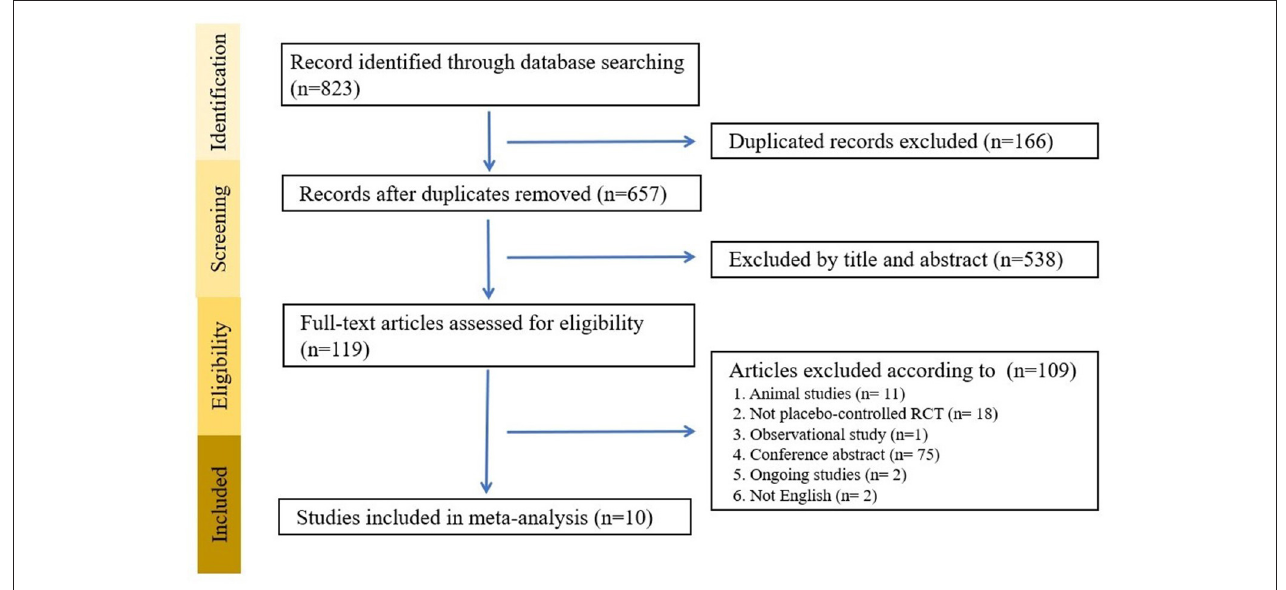
FIGURE 1 | Flow chart of the search